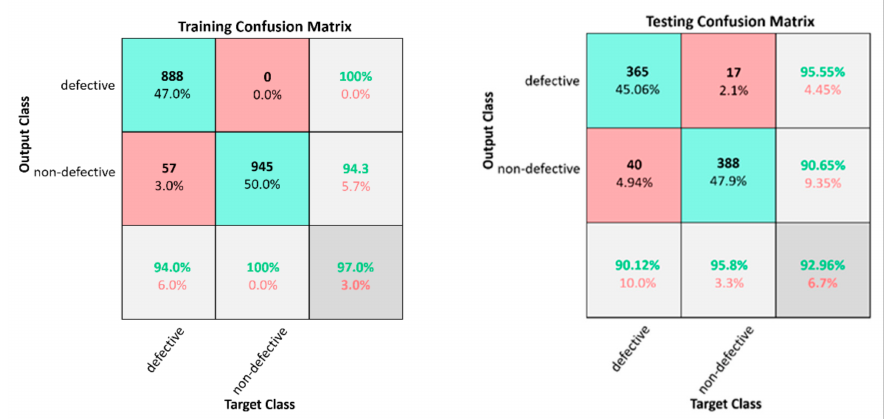
Figure 22. Confusion matrix for the classification using the AHE